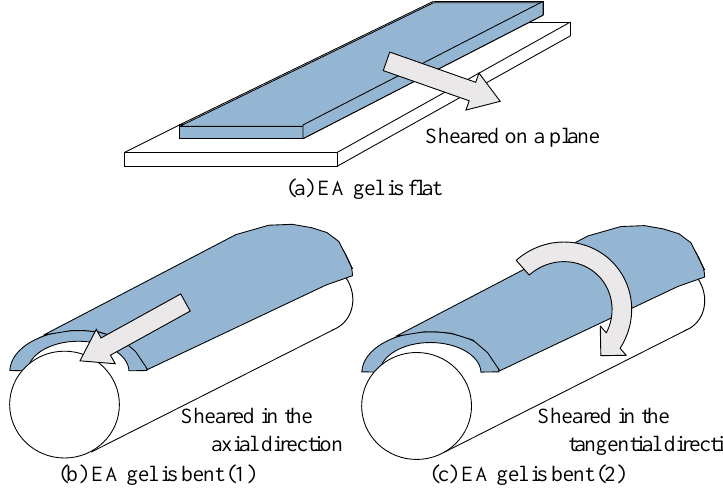
Figure 4. Bent types of EA